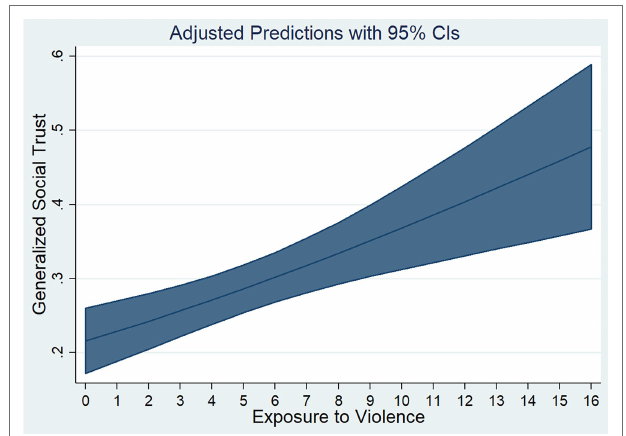
FIGURE 2 | Relationship between exposure to violence and generalized social